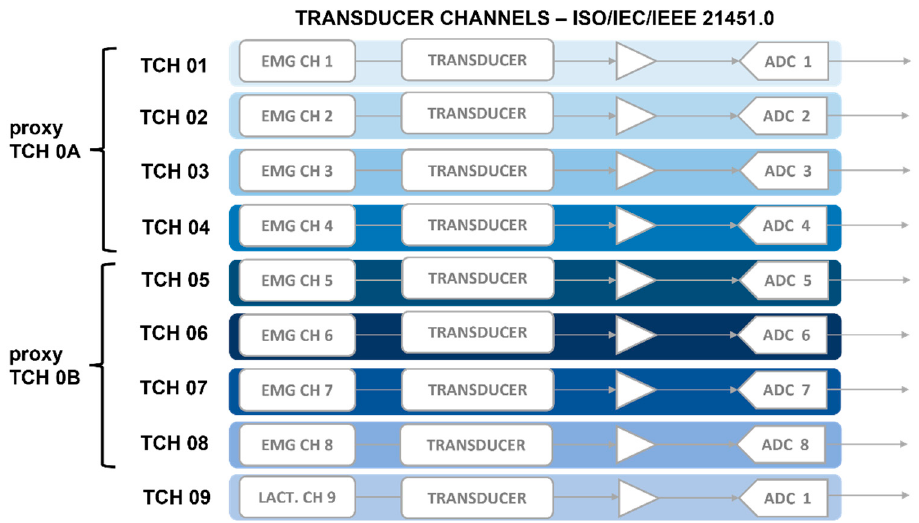
Figure 4. Standardized description compliant with the IEEE 21451 family of the local node described in Figure 2.